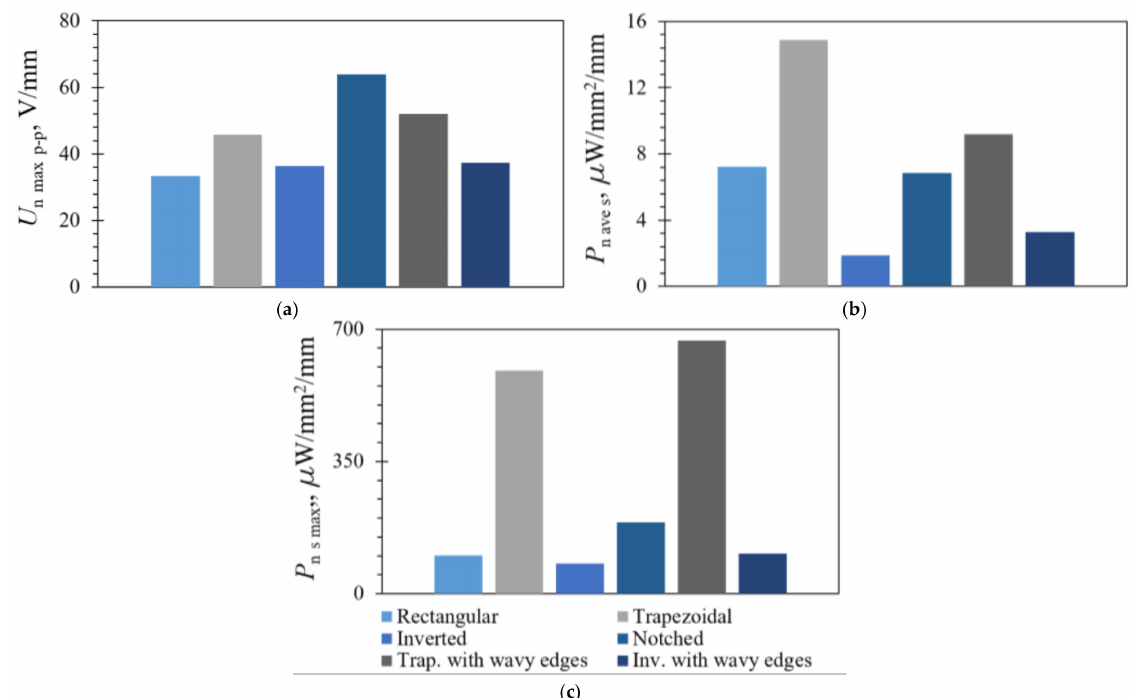
Figure 20. Normalized maximal voltages ( a ), as well as respectively calculated specific average ( b ) and specific maximal ( c ) power outputs for the considered bimorph PEH